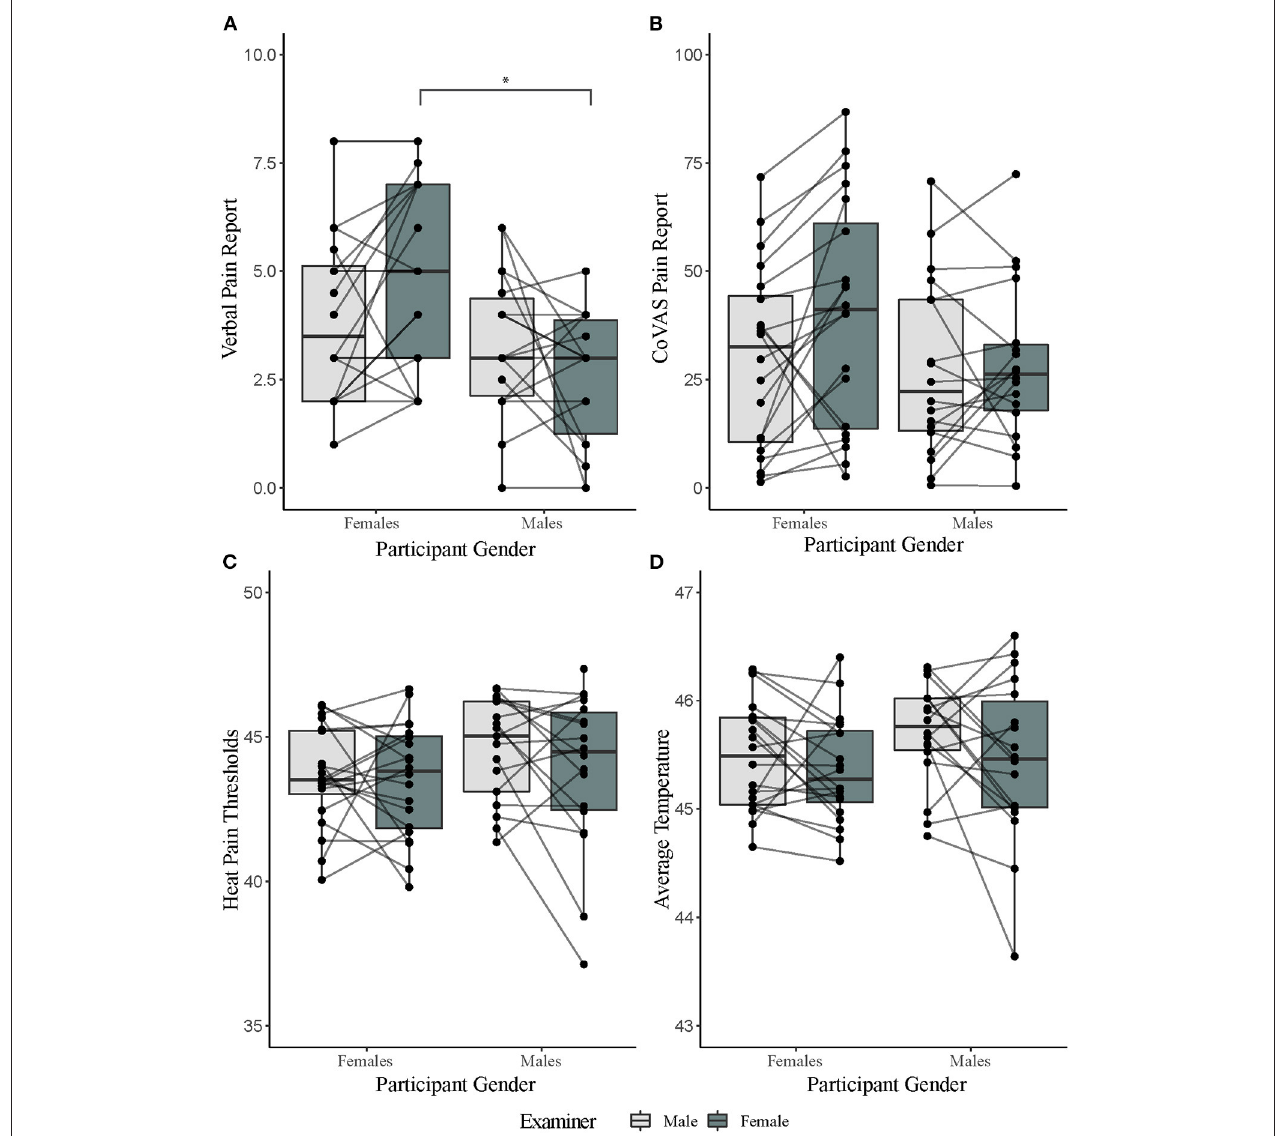
FIGURE 2 | Results of pain tests separated by participant and examiner gender. (A) Verbal pain reports for a 2-min tonic heat test separated by gender. (B) computerized visual analog scale (CoVAS) reports for a 2-min tonic heat test separated by gender. (C) Average heat pain threshold reports separated by gender. (D) PCT reports (as calculated by average temperature over a for a 2-min tonic heat test) separated by gender. *denotes significance level of p < 0.05 from Bonferroni corrected post hoc analysis.